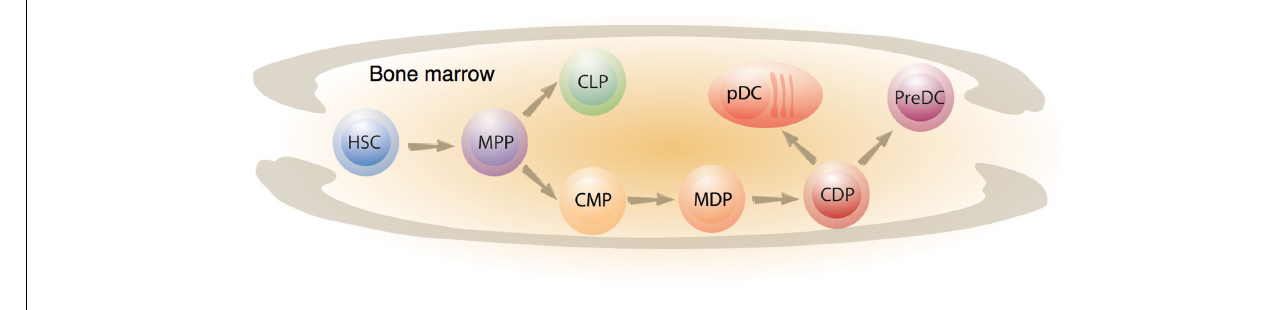
progenitor (MDP). Full commitment to the DC lineage is acquired at the CDP stage (common DC progenitor) where a CDP can either differentiate into plasmacytoid DCs (pDCs) or into a pre-DC.The latter will further differentiate into mature conventional DCs (cDCs) in the peripheral tissues, or secondary lymphoid